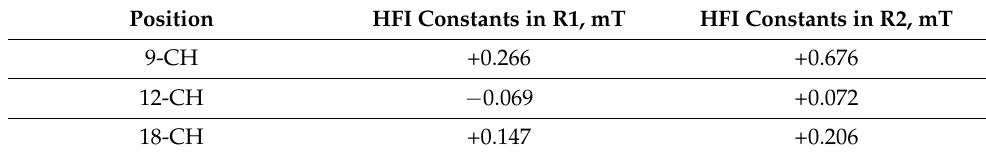
Figure 4. Two possible paramagnetic forms of GL. The glucuronide fragment of GL is omitted in the figure. ( a ) The radical anion of GL (R1), ( b ) ketyl ‐ type radical of GL (R2). Table 2 presents the calculated (DFT) values of the HFI constants in these radicals. Table 2. DFT calculation of HFI constants for two paramagnetic forms of GL. Position